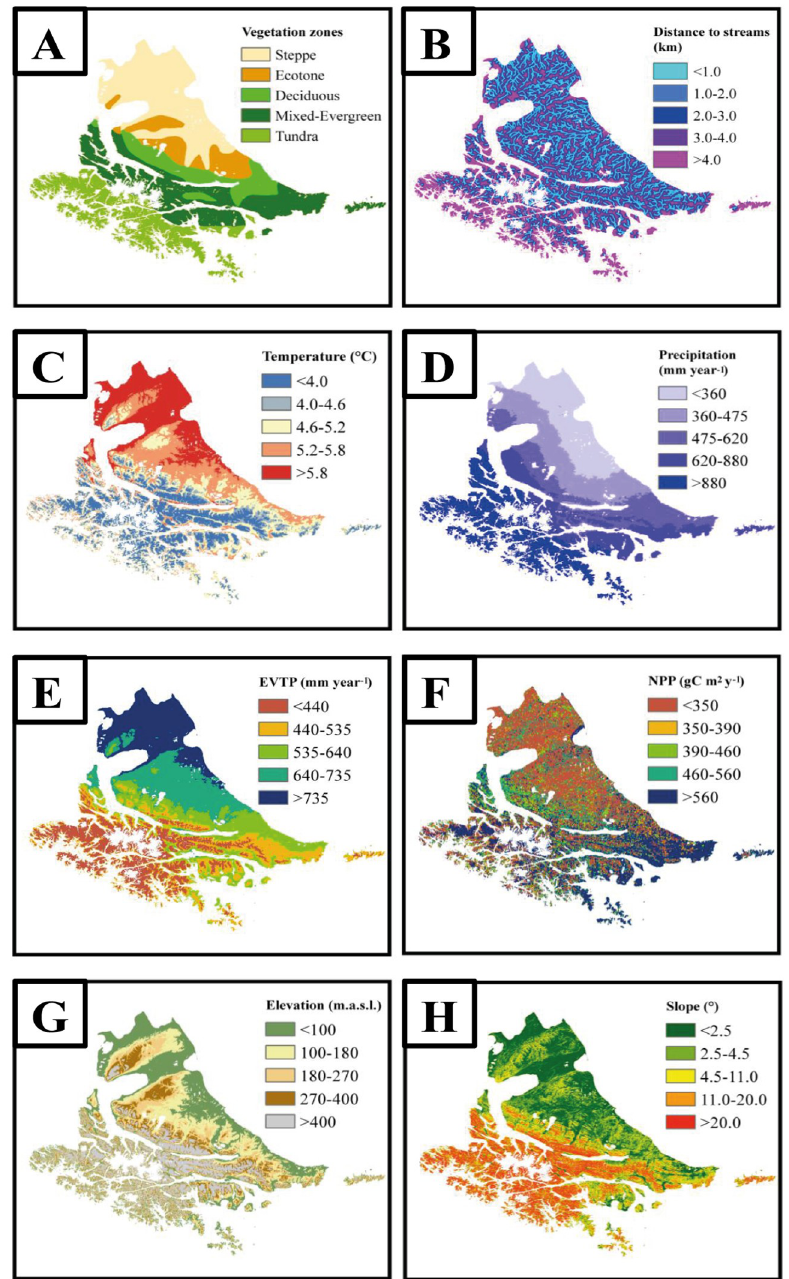
Fig 3. Distribution of the analyzed geographic (A-B), climatic (C-F) and topographic (G-H) factors on the Tierra del Fuego archipelago. (A) Vegetation zones were obtained from Borromei et al. (2014). (B) Distance to streams was obtained from https://earthengine.google.com/. (C) Temperature and (D) precipitation were obtained from http:// www.worldclim.org/version2. (E) Evapotranspiration (EVTP) was obtained from http://www.cgiarcsi.community/. (F) Net primary productivity (NPP) was obtained from http://files.ntsg.umt.edu/. (G) Elevation and (H) slope were obtained from https://earthengine.google.com/.